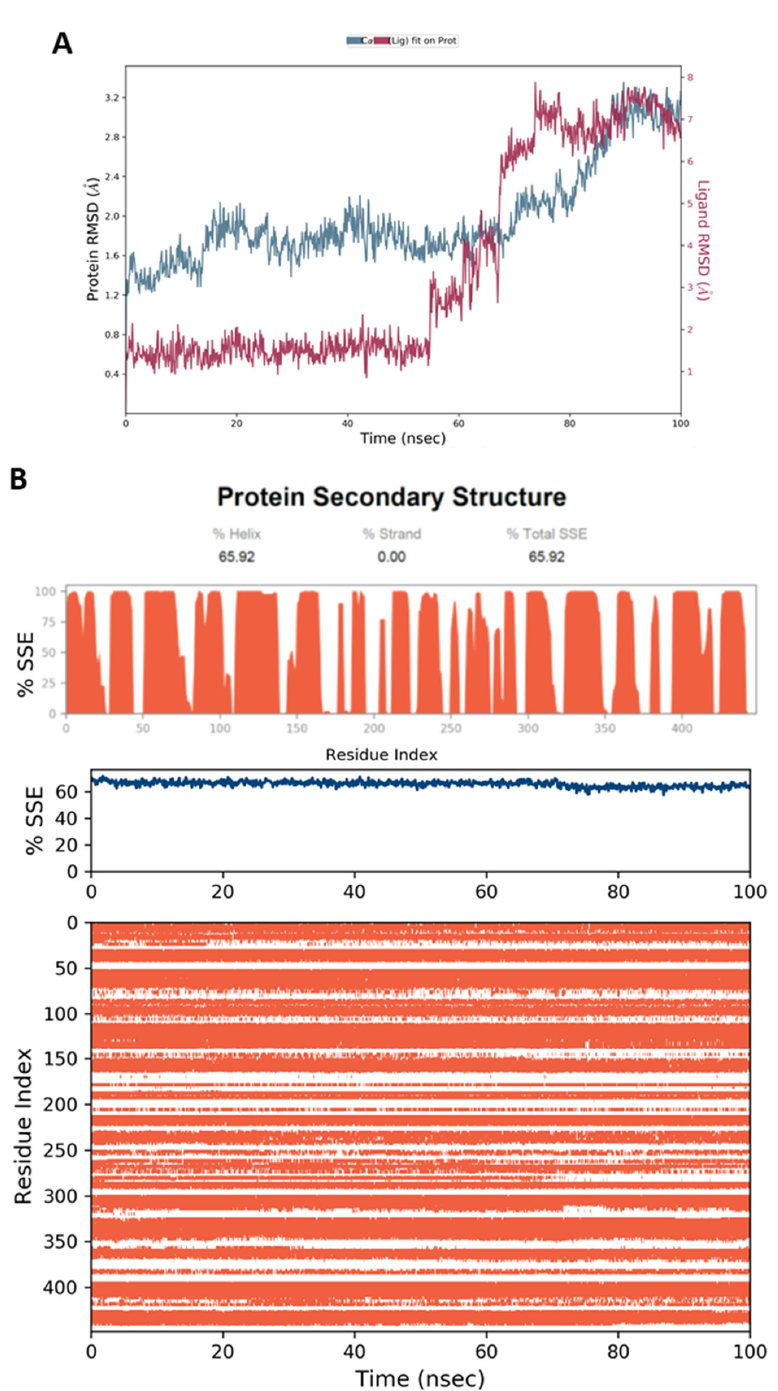
Figure 19. ( A ) RMSD graph for compound 60 when complexed with the GLUT1 protein (PDB ID: 5EQG). The simulation time (100 ns) confirmed the stability of the complex, with no significant changes in the protein structure. ( B ) Stability of the secondary structure GLUT1 protein (PDB ID: 5EQG) throughout the MD simulation when complexed with 60 . The protein secondary structure elements (SSE) were monitored during the simulation. The upper plot presents the SSE distribution according to residue index across the protein structure. The middle plot summarizes the SSE composition for each trajectory frame throughout the simulation, and the plot at the bottom monitors each residue and its SSE assignment over the simulation time.